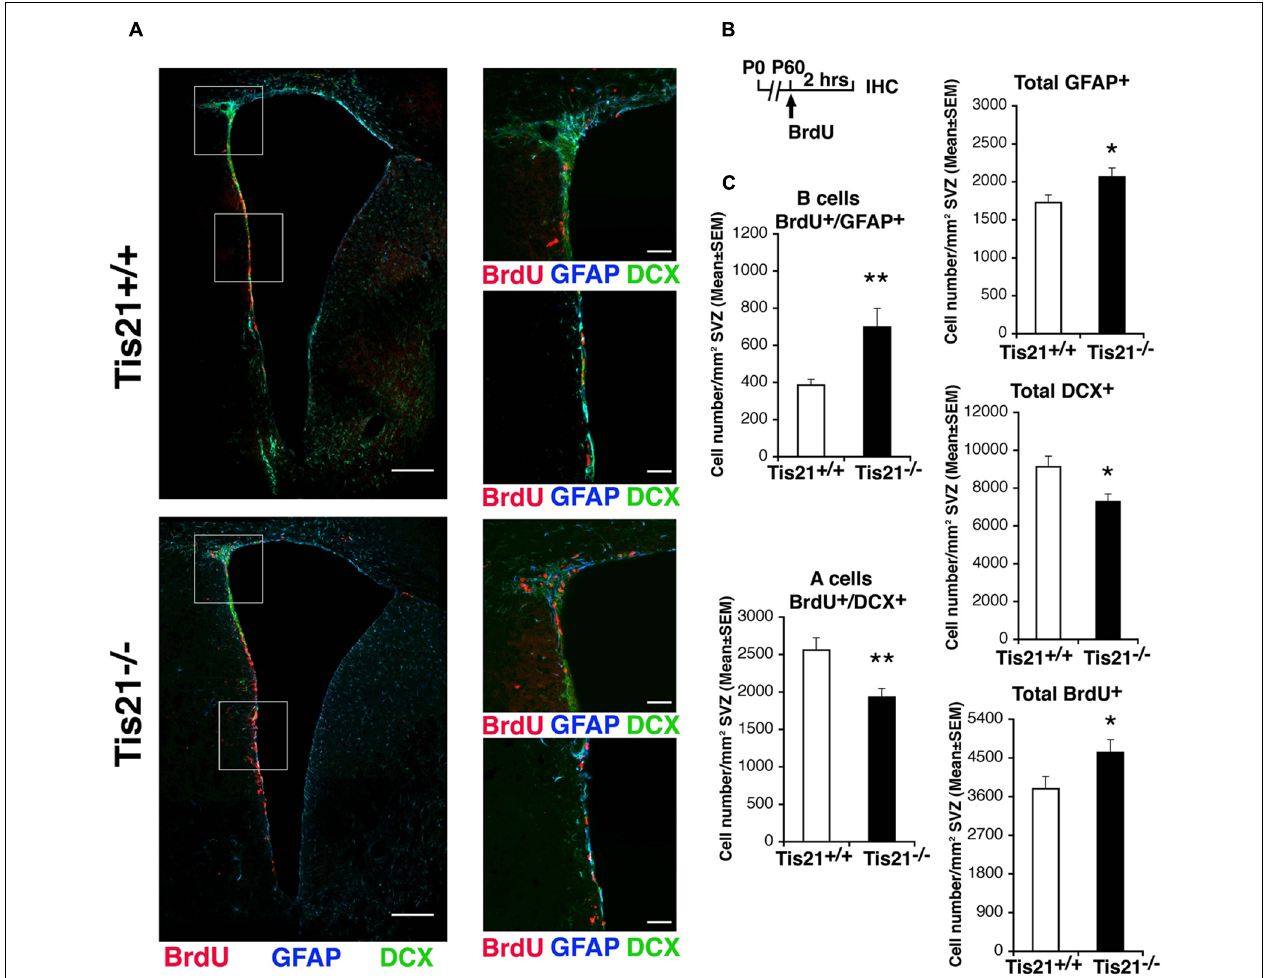
FIGURE 2 | Dividing stem cells increase while differentiating neuroblasts decrease in the SVZ of adult Tis21 knockout mice. (A) Representative confocal images of coronal sections of the SVZ in P60 Tis21 + / + and Tis21 − / − mice, showing dividing B stem cells, identified as double-labeled BrdU + /GFAP + cells (red and blue, respectively), and A neuroblasts, identified as double-labeled BrdU + /DCX + cells (red and green, respectively). On the right are higher magnification images of the dorsal and lateral SVZ areas indicated in white boxes. Scale bars, 200 μ m and